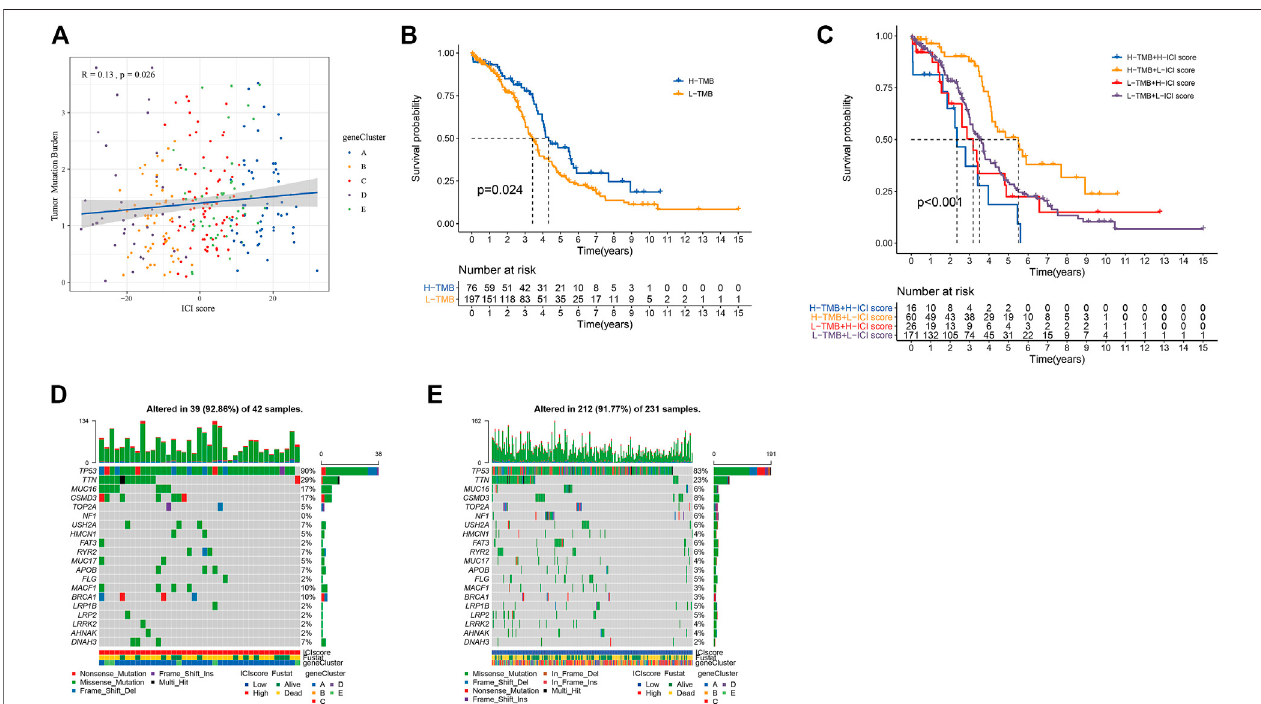
FIGURE 5 | The results of ICI score and somatic variation. (A) The scatter plot of the ICI score and mutation load ( p (cid:1) 0.0026). (B) Kaplan-Meier curve of the high TMBgroupandthelowTMBgroup(TCGA-OC, p (cid:1) 0.024). (C) Kaplan-MeiercurveofOCpatients(TCGA-OC, p < 0.001,useTMBmutationloadandICIscoretostratify patients). (D,E) are, respectively oncoPrint constructed based on ICI